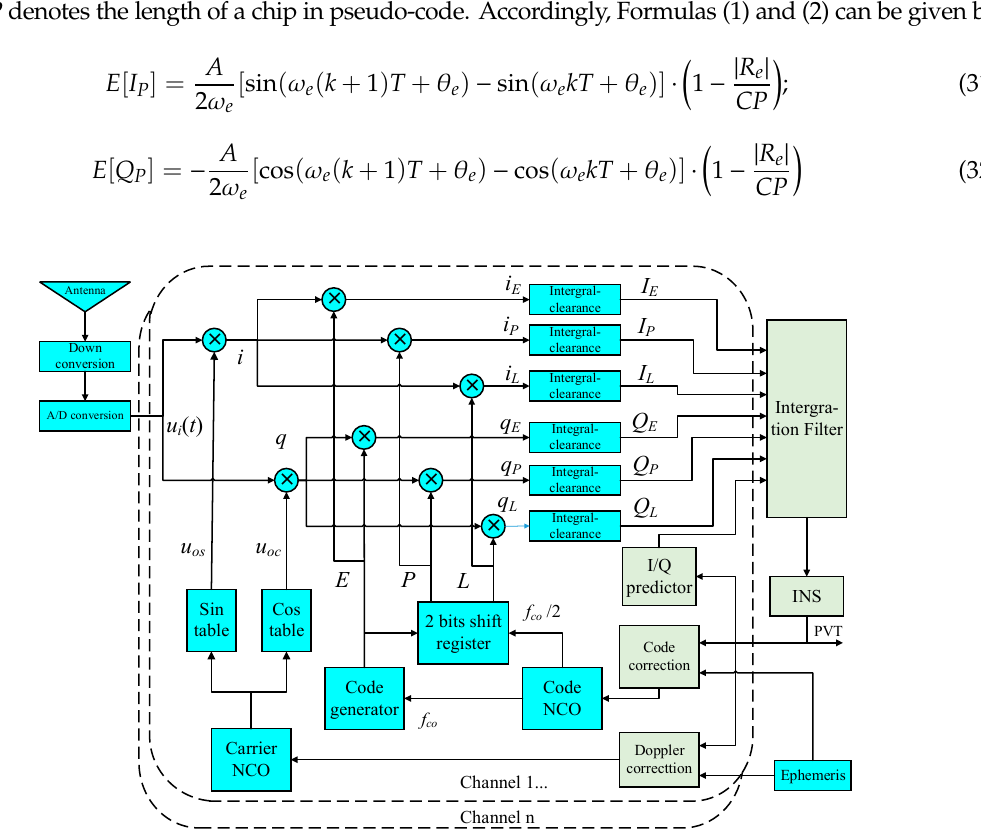
Figure 2. Ultra-tight integration considering code errors.